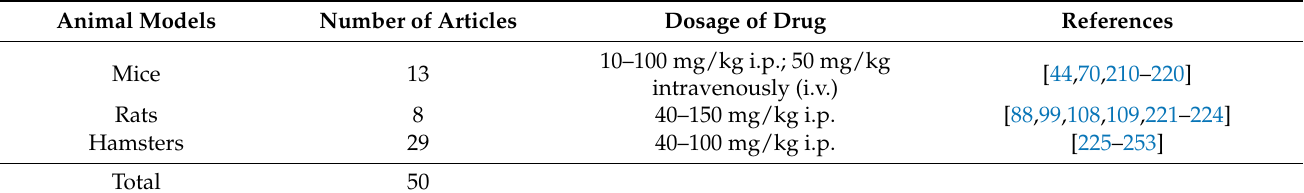
Table 5. Summary of data collected from in vivo animal studies involving 5-fluorouracil-induced oral mucositis. Drug concentrations obtained from studies are listed in a range of minimum to maximum dosage administered in animal models, including the route of